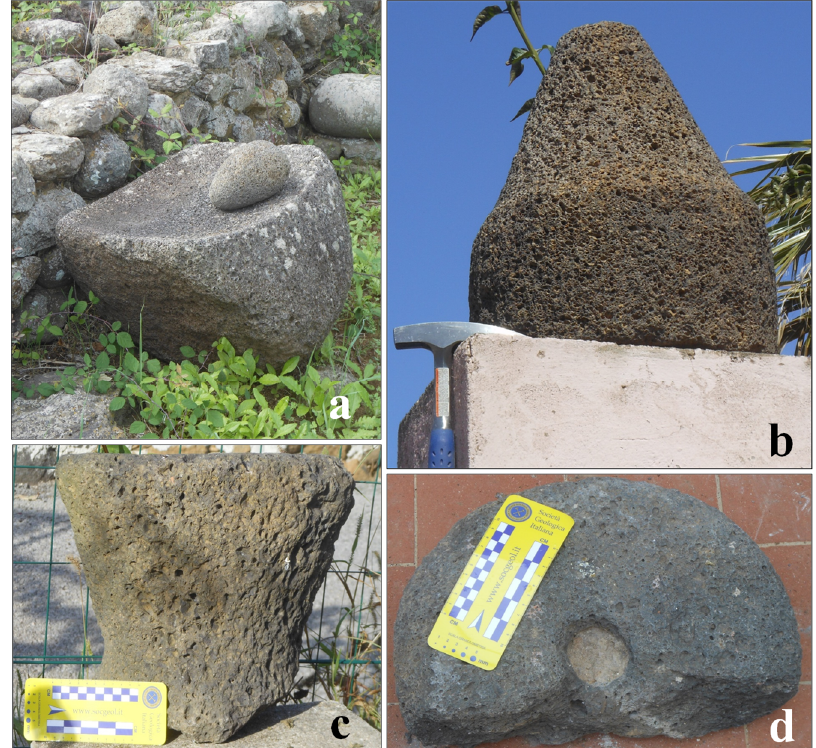
Figure 3. Representative millstone types found in Ustica Island: ( a )—large saddle quern; ( b )—meta of a rotary Morgantina-type millstone; ( c )—catillus of a rotary Morgantina-type millstone with a damaged (lacking) lower part; ( d )—rotary hand-mill. See text (materials and methods section) for the archaeological contexts.